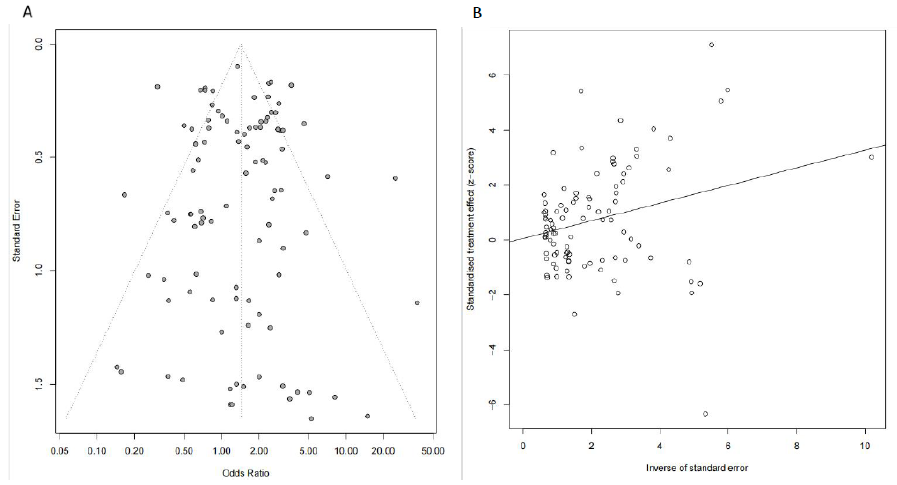
Figure 3. Publication bias was evaluated by Begg’s analysis ( A ) and Egger’s analysis ( B ).